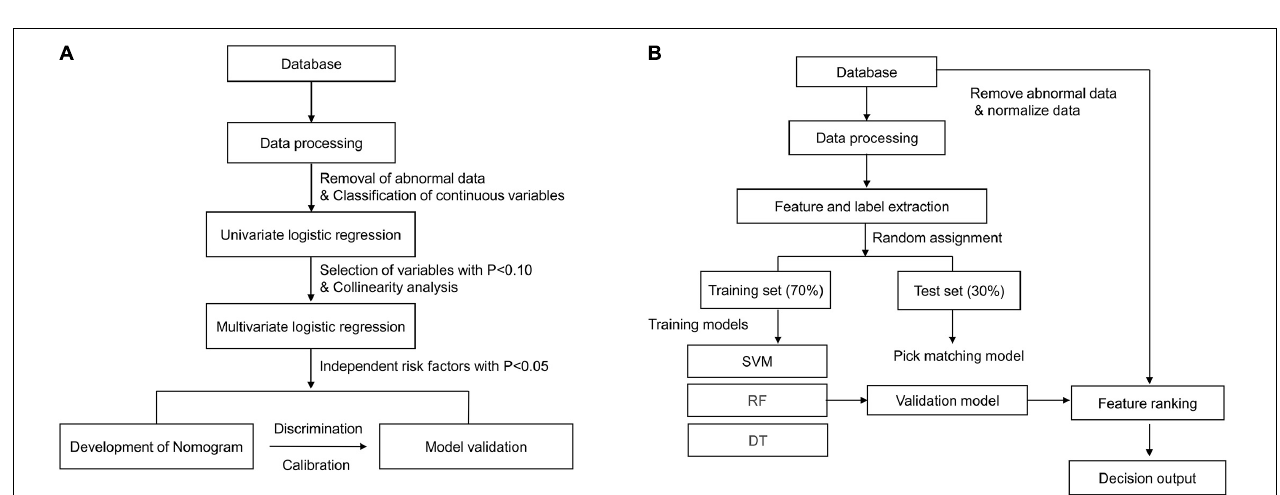
FIGURE 3 | (A) The process of development of nomogram. (B) The process of machine learning methods.